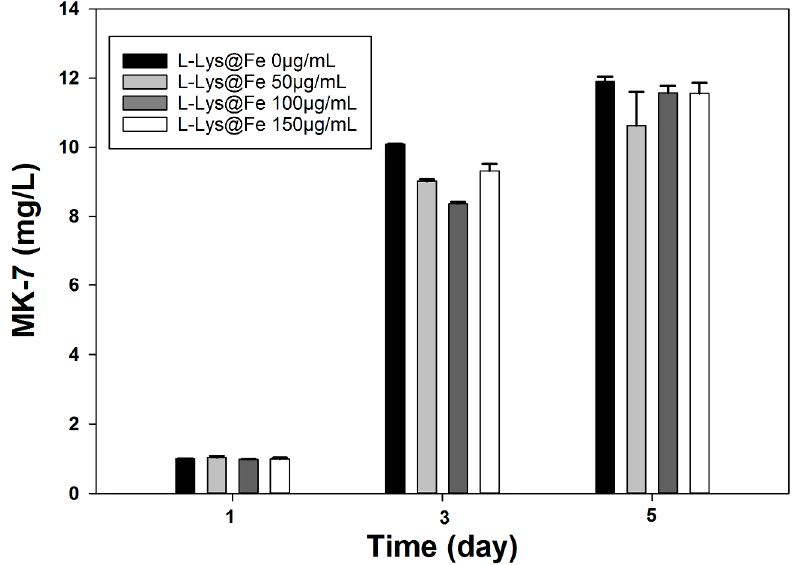
Figure 8. MK-7 production at different at L -lysine-IONs concentrations.